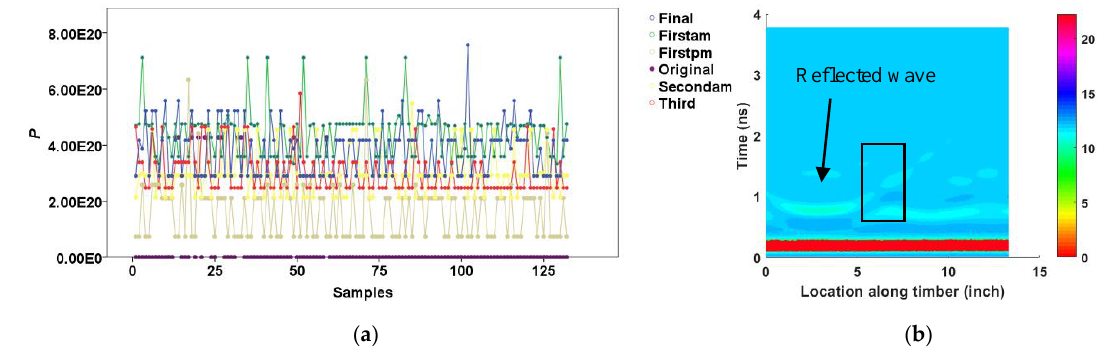
Figure 8. The comparison of the similarity values and the B-scan image of No. 6 core-sample. ( a ) The similarity values of core-samples with different moisture content (MC); ( b ) The radargrams of timber sections inserted with No. 6 core-sample.